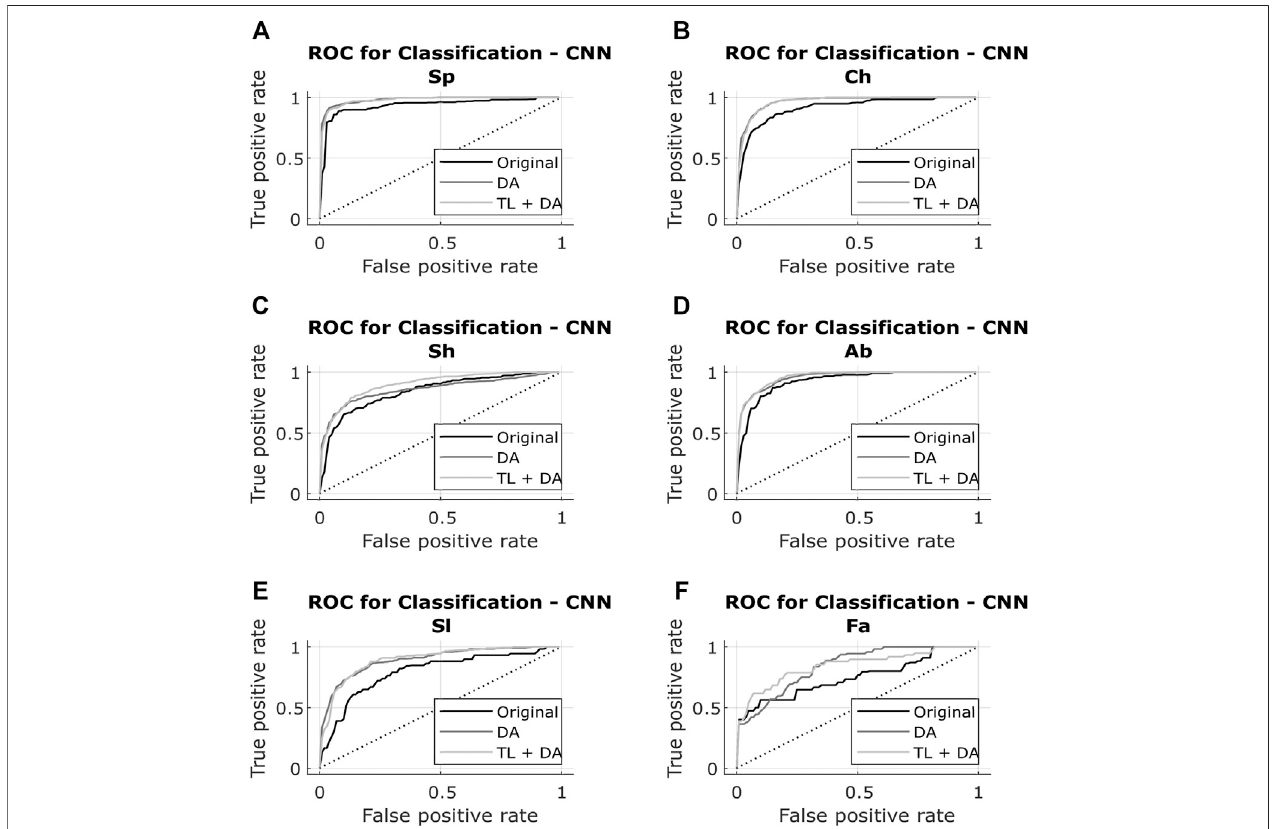
FIGURE 6| ROC of the CNN models for each ofthe sub-groups of the BS dataset (A) Spontaneous breathing(Sp) (B) Chestbreathing (Ch) (C) Shallow breathing (Sh) (D) Abdominalbreathing(Ab) (E) Slowbreathing(Sl) (F) Fastbreathing(Fa).ThecurvespresentthemedianROCforeachmodel,inblacktheoriginal,indarkgraythe CNN-DA and in light gray the CNN-TL + DA. The dotted line corresponds to the random guess. It is observed that the models DA and TL + DA exhibit a better behavior than the Original one, while behaving similar to each other.